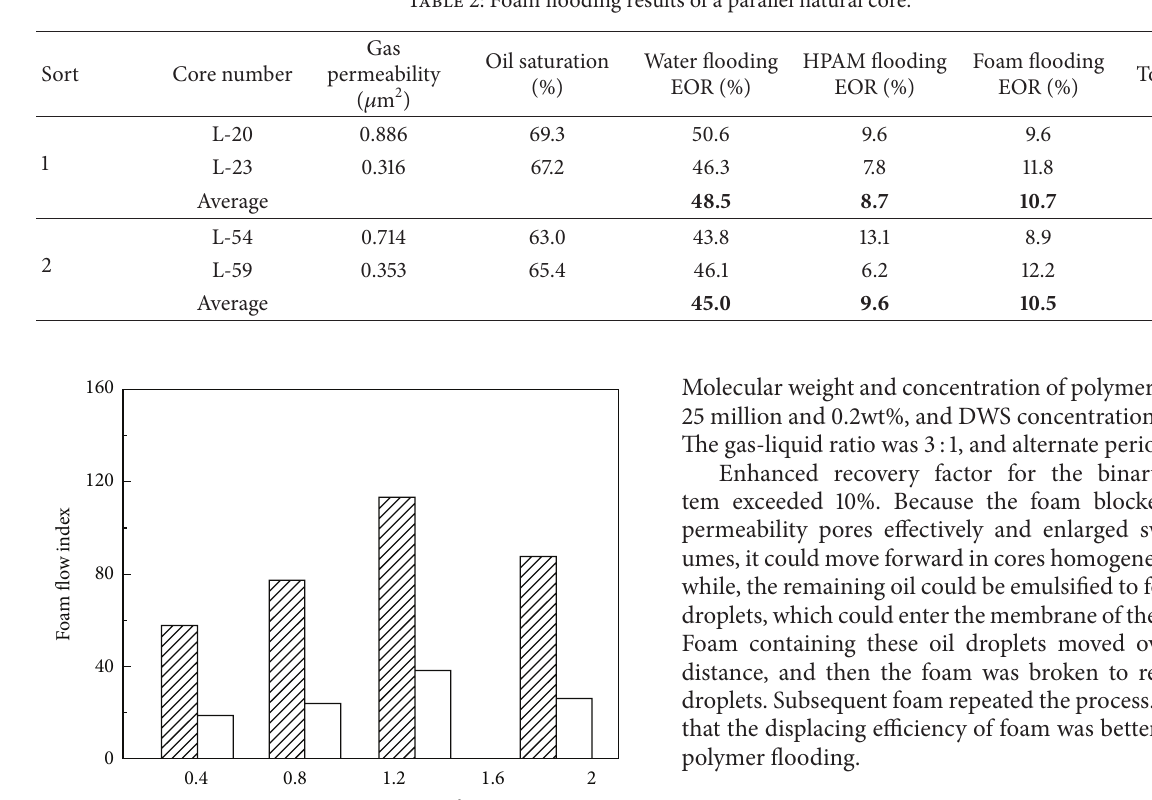
Table 2: Foam flooding results of a parallel natural core.